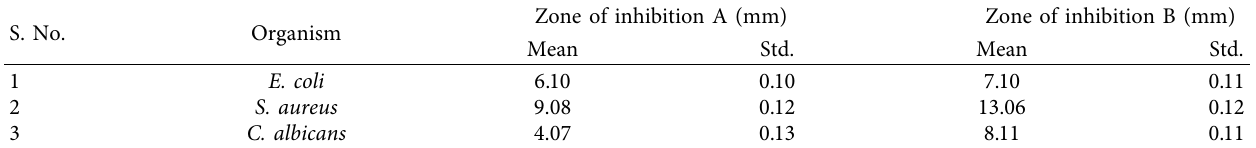
Table 3: Antimicrobial performance of